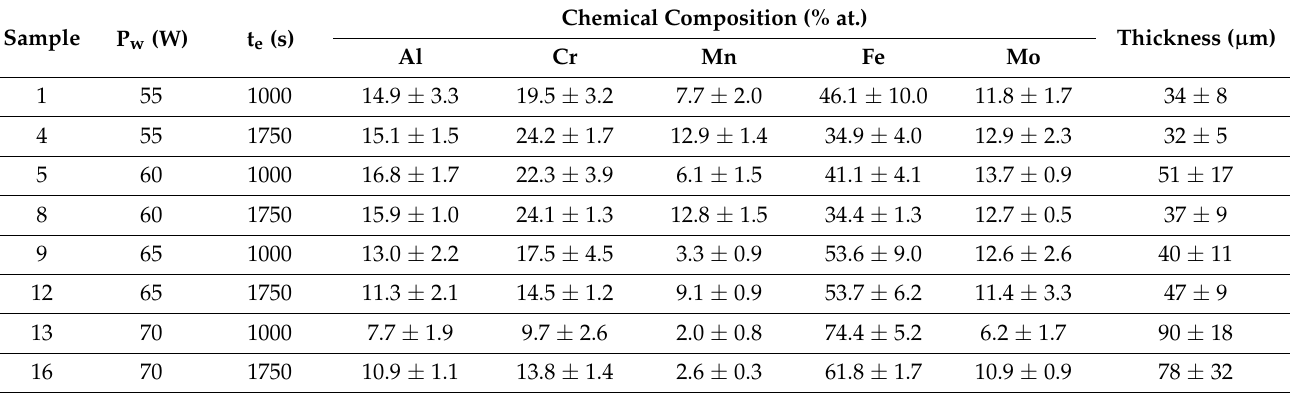
Table 2. Results of chemical composition by EDS and thickness of coatings deposited with H s and d p of 50 µ